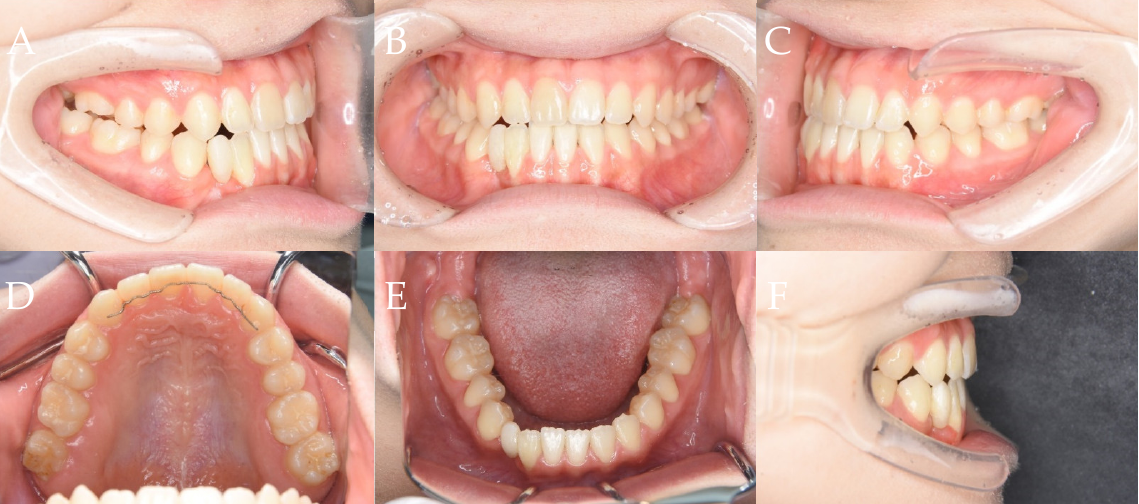
Figure 9. Post-treatment intraoral photographs right after debonding all orthodontic appliances. ( A ) Right side view; ( B ) front view; ( C ) left side view; ( D ) upper occlusal view; ( E ) lower occlusal view; ( F ) incisal view.